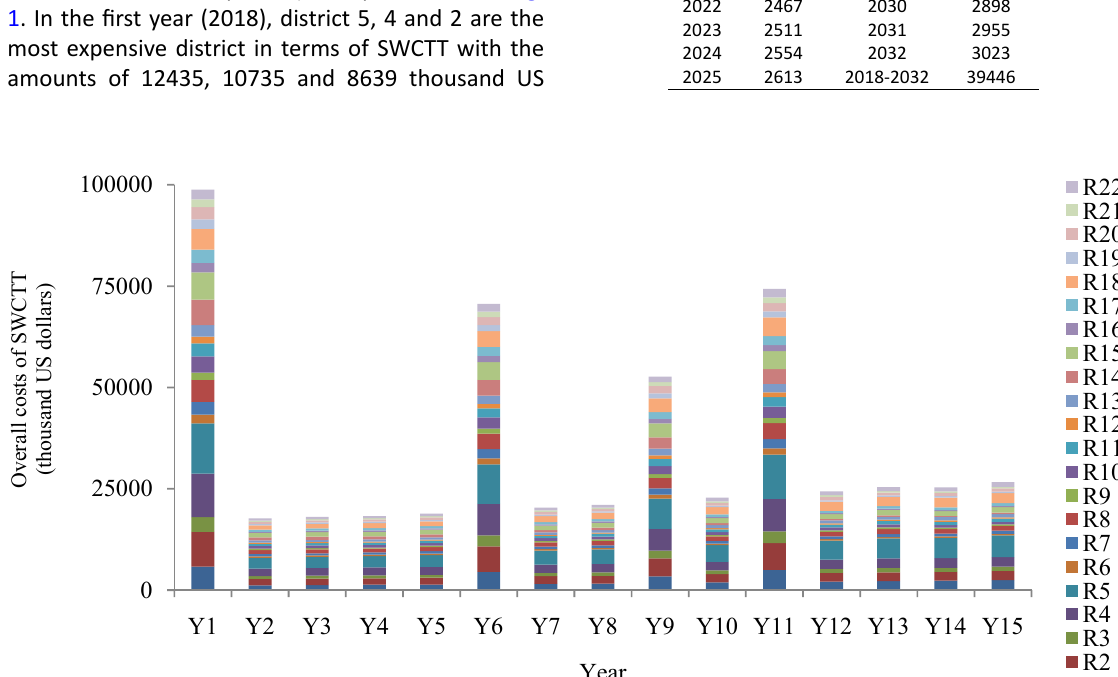
Fig. 1. Projected the overall costs for SWCTT in different district of Tehran from Fig. 1: Projected the overall costs for SWCTT in different district of Tehran from 2018‐2032